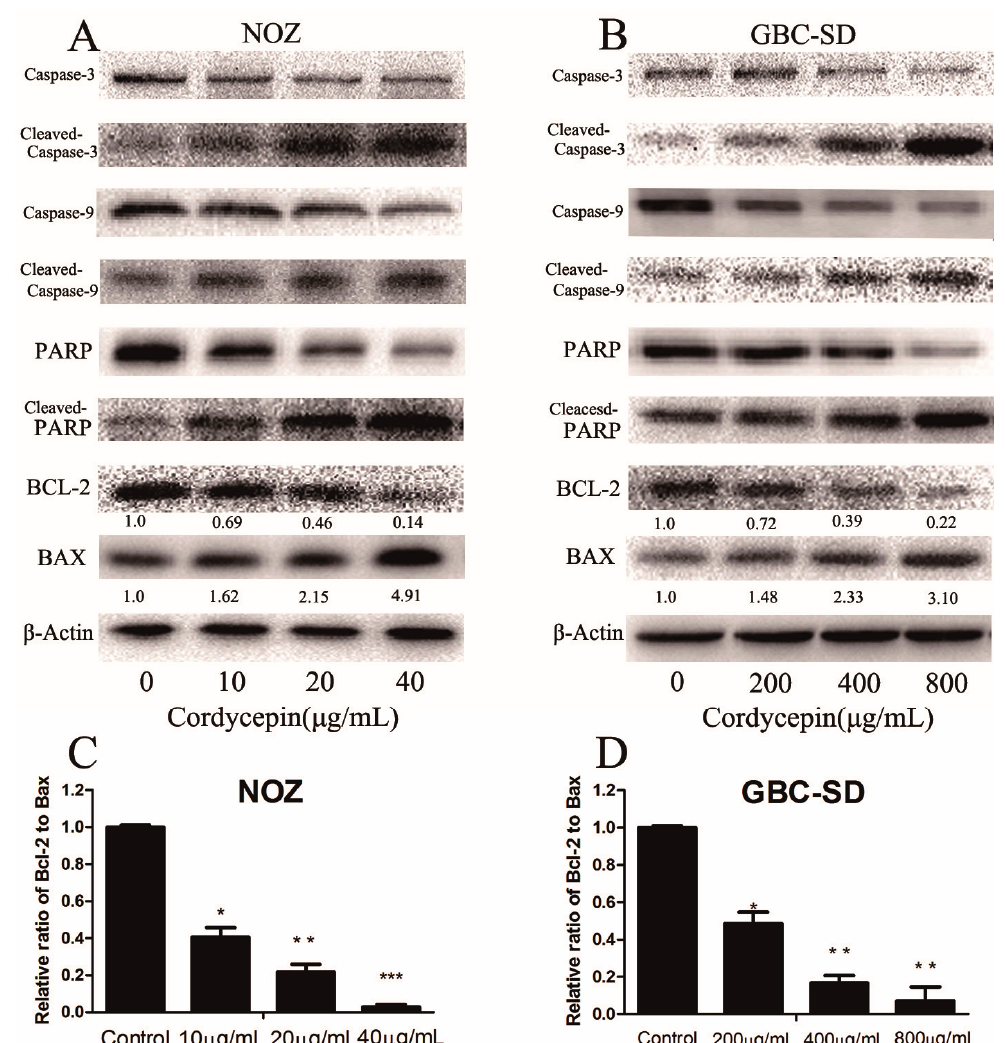
Figure 6. Cordycepin regulates the expression of apoptosis-related proteins in human gallbladder cancer